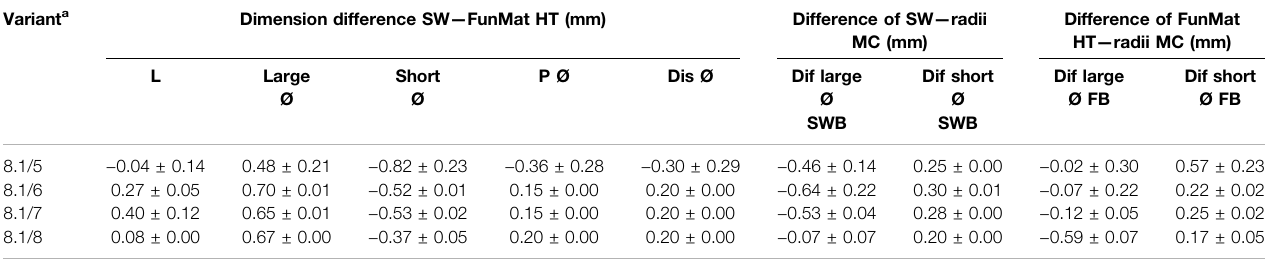
TABLE 9 | Dimension differences between designed (SW), 3D-printed (FunMat HT and F) radii PEEK plugs and radii medullary cavity (MC).